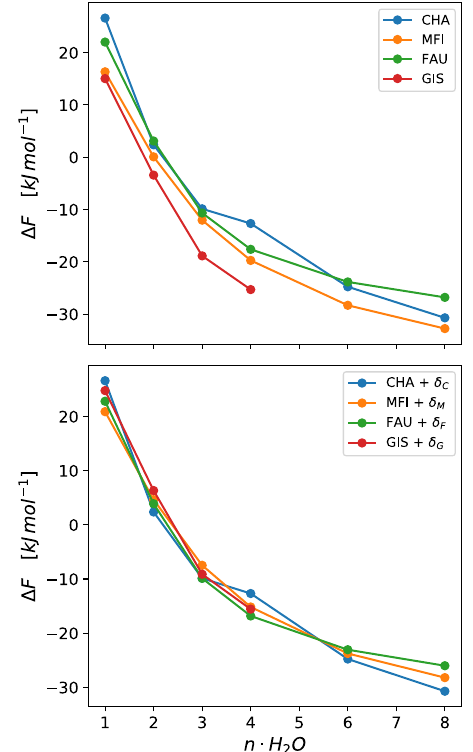
Fig. 6 Deprotonation free energies. Reaction free energies between states A and B + C as a function of the water loading (top panel) and same curves rescaled by a factor δ that minimizes the offsets among them (bottom